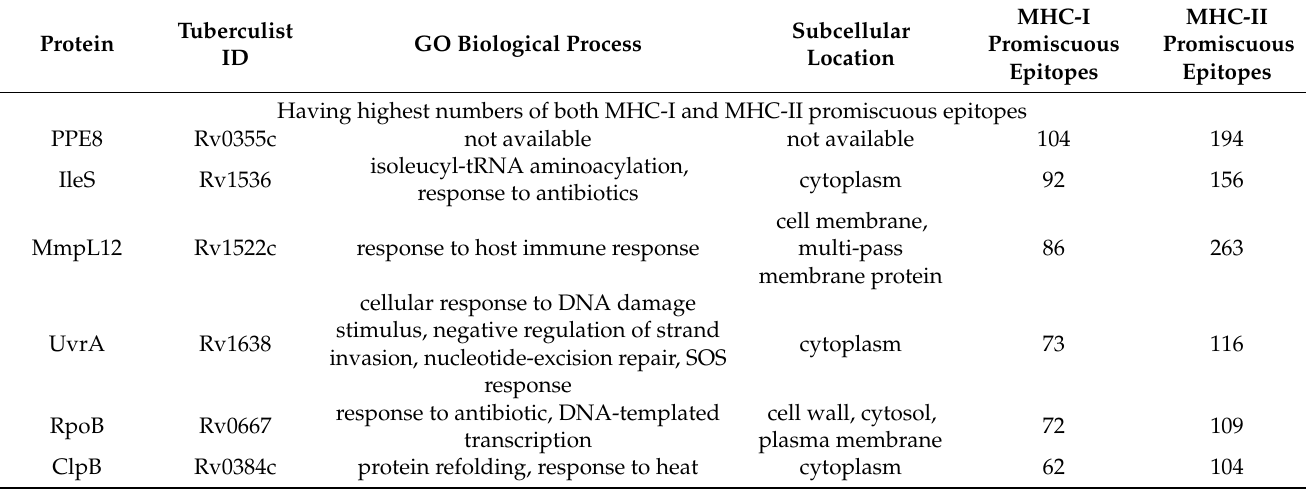
Table 3. Final selection of prospective novel MTB vaccine candidates with sufficiently high Vaxign-ML protegenicity scores, belonging to the protein family of an established PAg and/or having a biological process related to the virulence or latency of MTB, and having the greatest number of MHC-I and/or MHC-II promiscuous